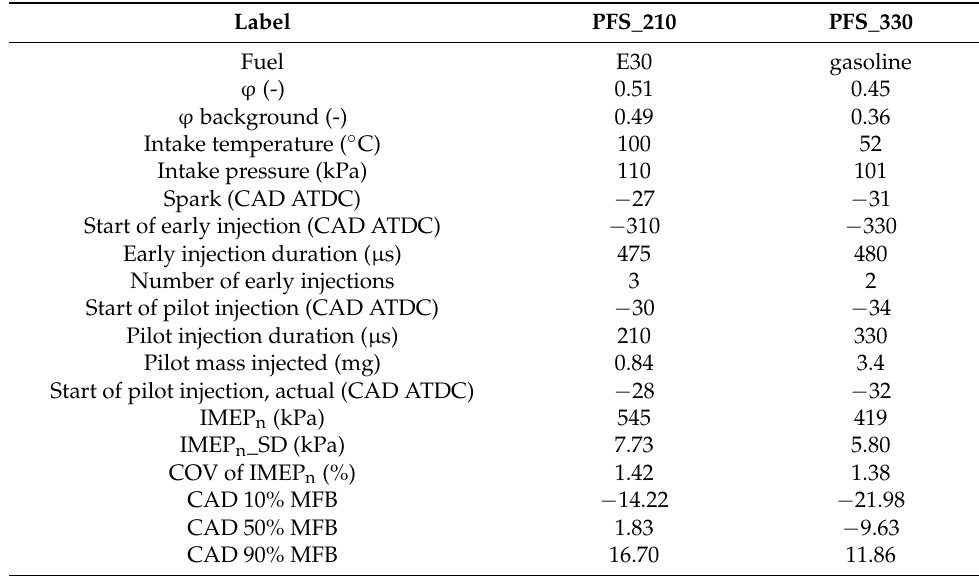
Table 5. Operating conditions for partial fuel stratification combustion analysis. Engine speed is 1000